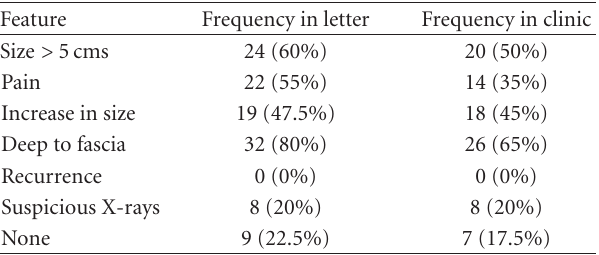
Table 2: Frequency with which clinical features in DoH referral guidelines appeared in referral letters and after review in our cen-